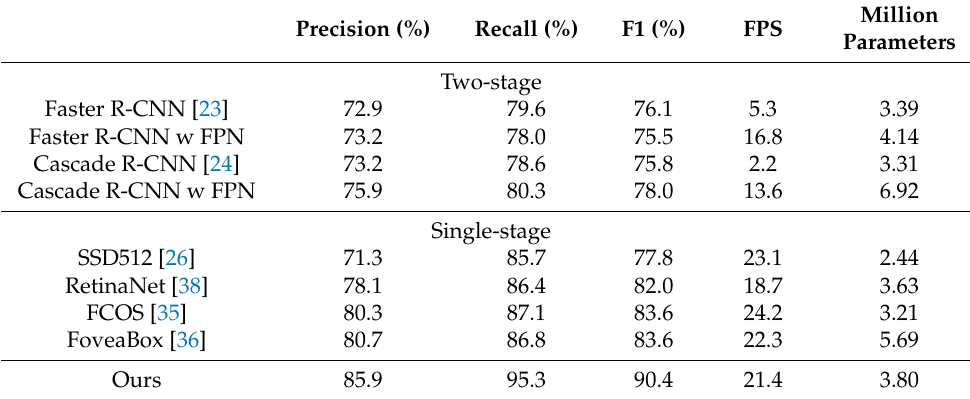
Table 4. Comparison of multiple detection methods in RSI.